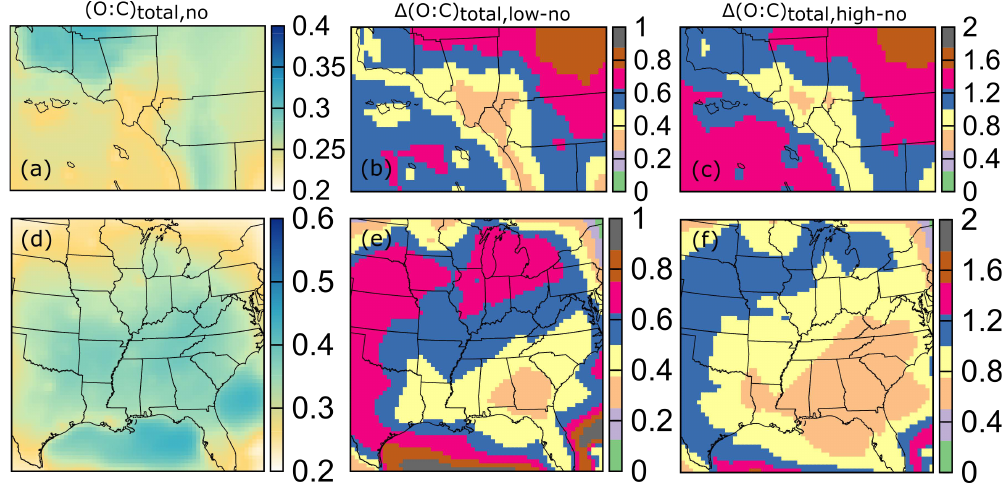
Figure 7. 14-day averaged O:C atomic ratios for total OA (POA + SOA) for (a) SoCAB and (d) the eastern US for the SOM-no simulations. The normalized difference in O:C, (cid:49) (O:C), between the SOM-low or SOM-high and SOM-no simulations, where (cid:49) (O:C) is defined as ((O:C) SOM-low/high -(O:C) SOM-no )/ (O:C) SOM-no ) , is shown in panels (b–c) for SoCAB and (e–f) for the eastern US. In all cases, the O:C for POA was assumed to be